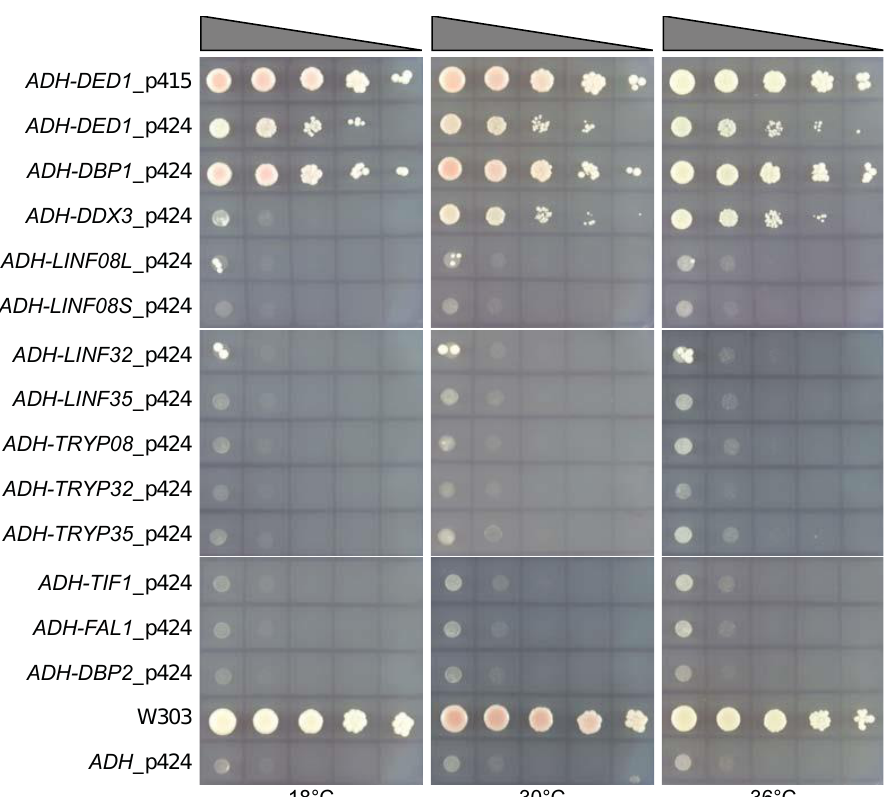
Figure 4. Complementation of the genes in a ded1 -deletion strain. The listed genes in the HA-p415 centromeric or HA-p424 2µ plasmids were constitutively expressed in the ded1::HIS yeast strain from the strong ADH promoter, and then cultures were serially diluted by factors of 10 and spotted on SD plates containing 5-FOA that were subsequently incubated at the indicated temperatures. Plates were incubated three days at 30 °C and 36 °C, and for 7 days at 18 °C. W303 is a wildtype strain expressing endogenous DED1 . TIF1 , FAL1, and DBP2 encode yeast DEAD-box proteins that are unrelated to the Ded1/DDX3 subfamily. DDX3X is the human protein and DBP1 is the yeast paralog of DED1 that suppresses the DED1 deletion when overexpressed. ADH _p424 is the empty plasmid. Similar results were obtained with proteins expressed off the p415 plasmid.